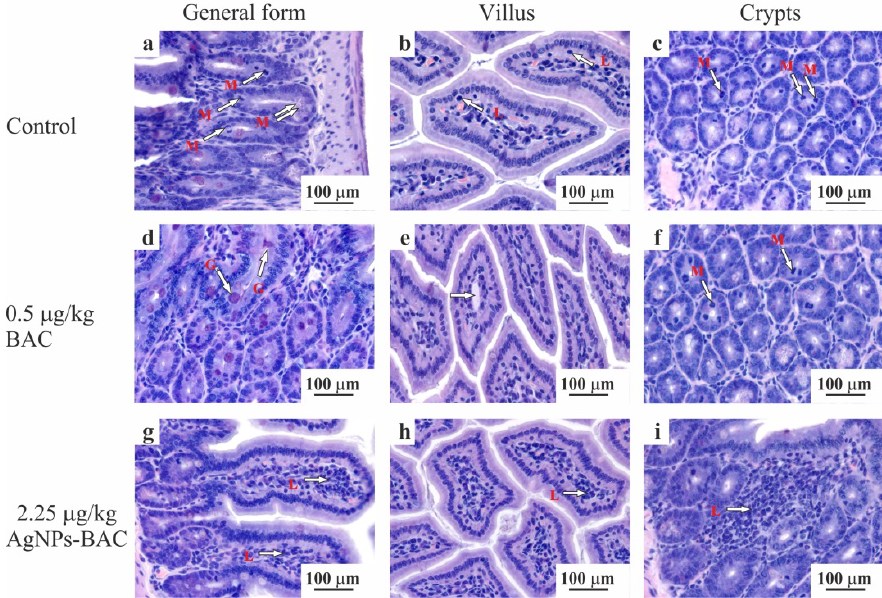
Figure 6. Jejunum histology section of the animals from the control ( a – c ) and experimental ( d – i ) groups. The micrographs show a general form ( a , d , g ), the structure of the villus ( b , e , h ) and crypts ( c , f , i ). Hematoxylin-eosin staining, ×10 magnification. M—mitotic phase cells (in ana-, meta- and telophase), L—lymphocytes, G—goblet cells mucus.